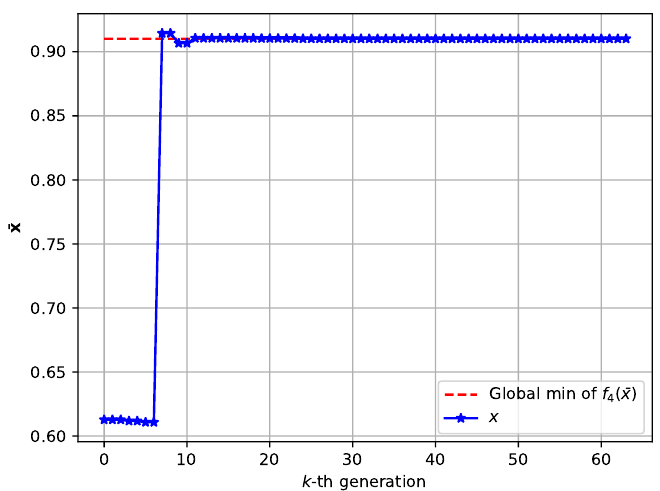
Figure 20. Convergence of the dimension x of f 4 ( ¯x ) in slave node.